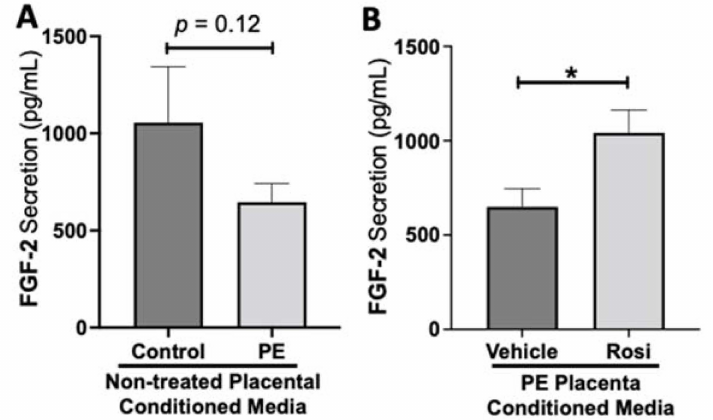
Figure 5. Fibroblast Growth Factor 2 shows reduced secretion from the preeclamptic placenta that is reversed by Rosiglitazone treatment. Secretion of Fibroblast Growth Factor 2 (FGF-2) was measured via Luminex assay from conditioned media from non-treated control and preeclamptic (PE) placentas ( A ) and vehicle- or Rosiglitazone (Rosi)-treated PE placentas ( B ). FGF-2 secretion appears to be reduced in preeclamptic placenta however this decrease is not statistically different from control placentas ( A , n > 10). Rosi-treated PE placentas show a significant increase in FGF-2 secretion compared to the vehicle control ( B , n = 14). (Protein secretion was measured by a Luminex assay where experimental values were determined relative to a standard curve. Statistical analysis was performed by student’s t -test to determine significant differences between groups, * p < 0.05, bar plots and data reported are reported as mean pg/mL values ±